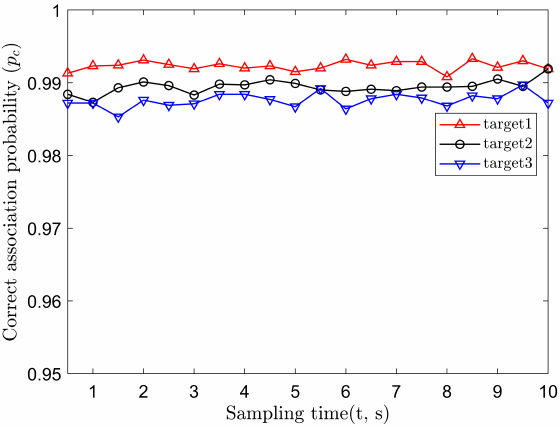
Figure 4. Probability of correct association.